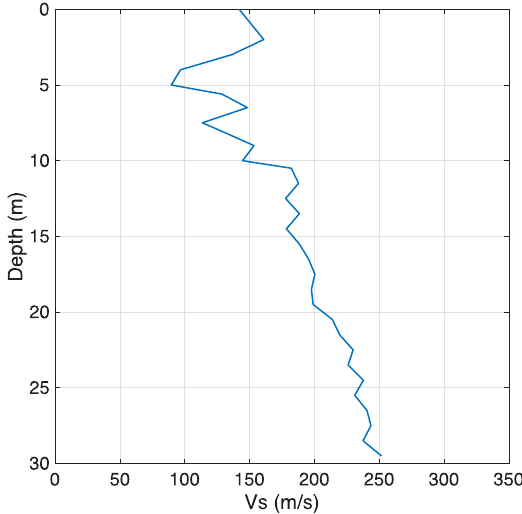
Figure 5. Shear wave velocity profile for the BOWW soil profile.